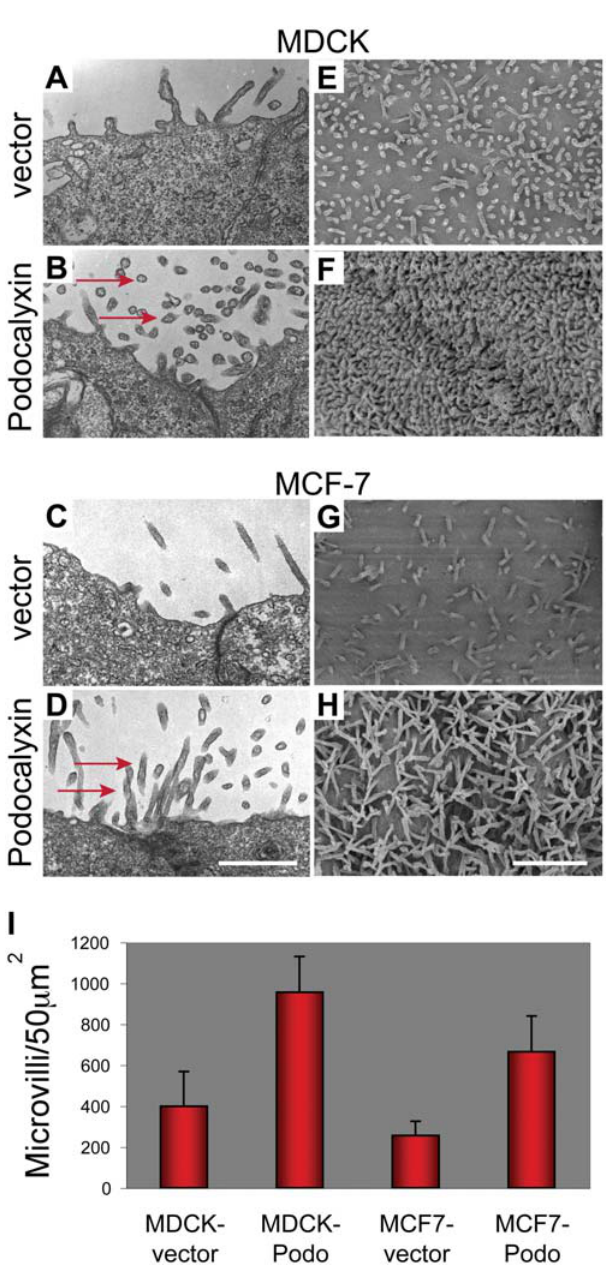
Figure 1. Podocalyxin induces microvillus formation. MDCK (A, B, E, F) and MCF-7 (C, D, G, H) cells transfected with murine Podocalyxin (B, D, F, H) or empty vector (A, C, E, G) and examined by TEM (A–D; scale bar: 1 m m) and SEM (E–H; scale bar: 2 m m). In TEM images, vertical slices are shown near the apical cell surface with some of the numerous additional microvilli labeled with red arrows. Many microvilli are visible as small circles as they are seen in cross-section. SEM images are of the apical cell surface with microvilli evident as thin surface projections. (I) Microvilli in six 50 m m 2 fields were enumerated and graphed. Averages are shown; error bars represent standard deviation. T-tests were used to show statistically significant differences between vector and Podoca- lyxin-transfected cells, with p , 0.002 in both cases. Representative of two independent experiments.